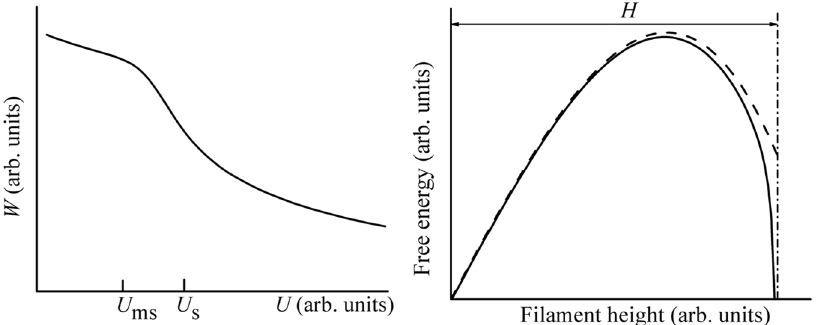
Figure 4. Left : A sketch of the FIN barrier voltage dependence, linear in low voltage region and hyperbolic for higher voltages. Right : The filament free energies with (solid line) and without (dashed line) the tip electrode interaction [the last term in Eq. (12)] taken into